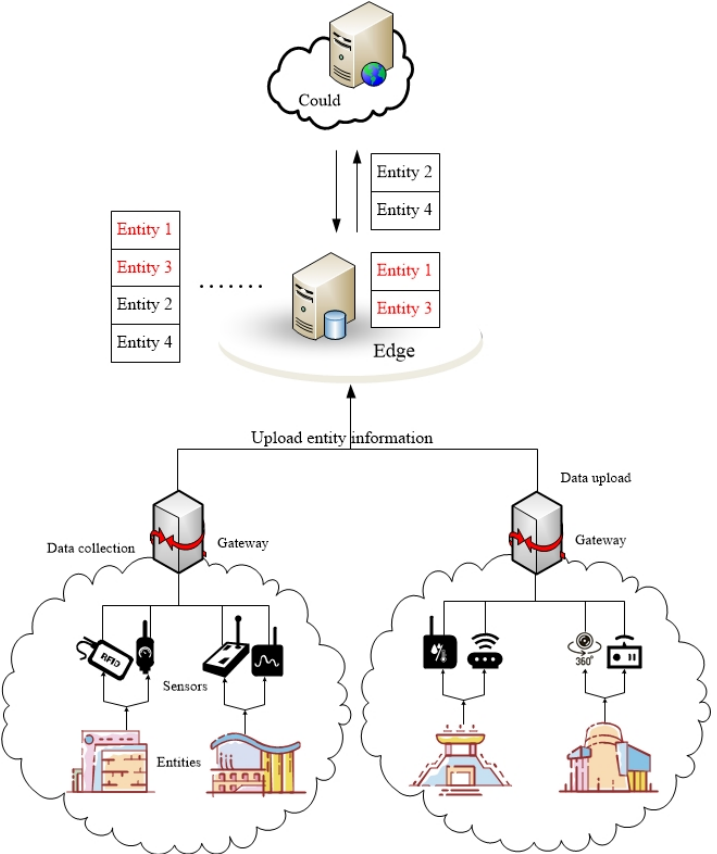
Figure 2. Entity recognition classification